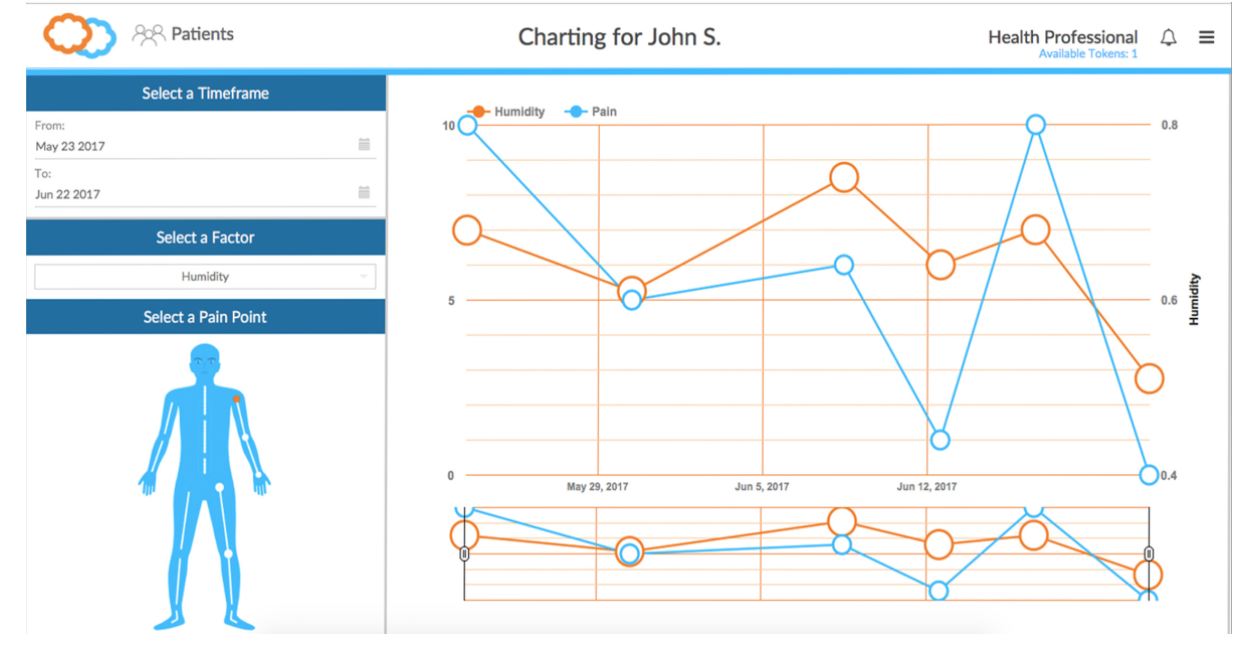
Figure 3. Web portal.